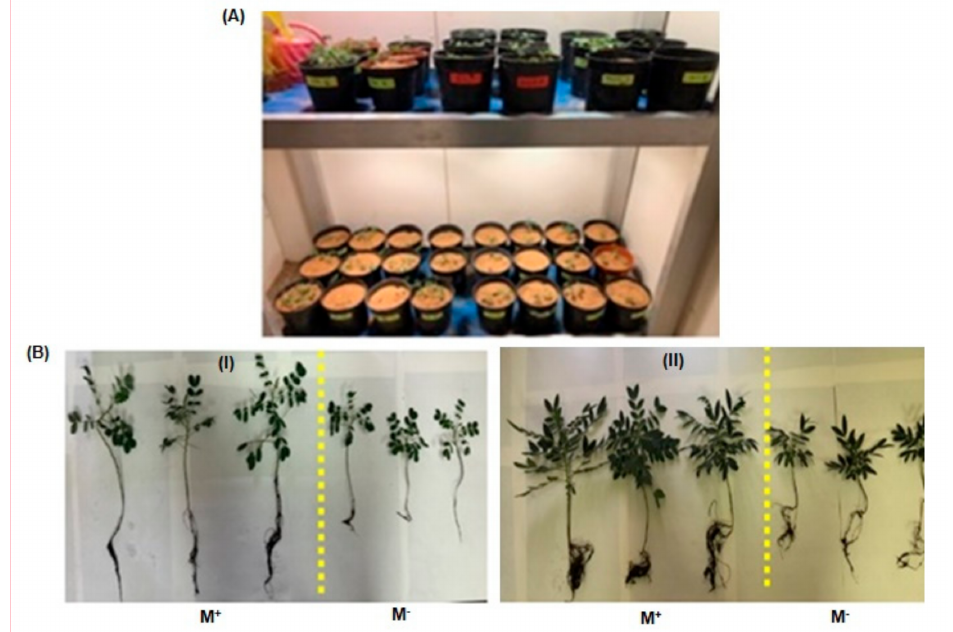
Figure 2. ( A ) Cultivation of S. alexandrina and S. italica plants in the growth chambers of the College of Food and Agricultural Sciences at King Saud University. ( B ) The changes in the characteristics of growth of S. italica (I) and S. alexandrina (II) in the presence and absence of mycorrhizal